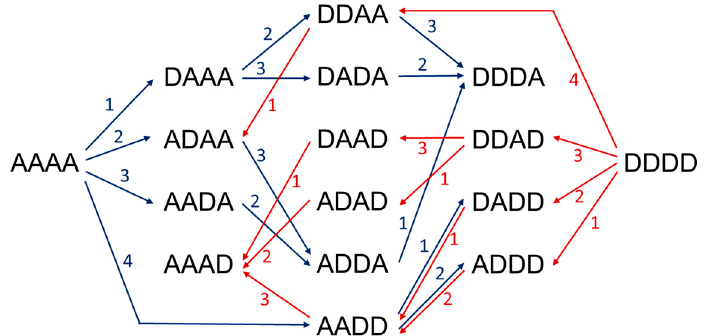
Figure 7. Production routes of all possible chitin and chitosan tetramers using 4 different CDAs to specifically deacetylate or N -acetylate paCOS. A: GlcNAc, D: GlcNH 2 . Blue arrows, deacetylation reactions, red arrows, N -acetylation reactions in the presence of excess acetate.